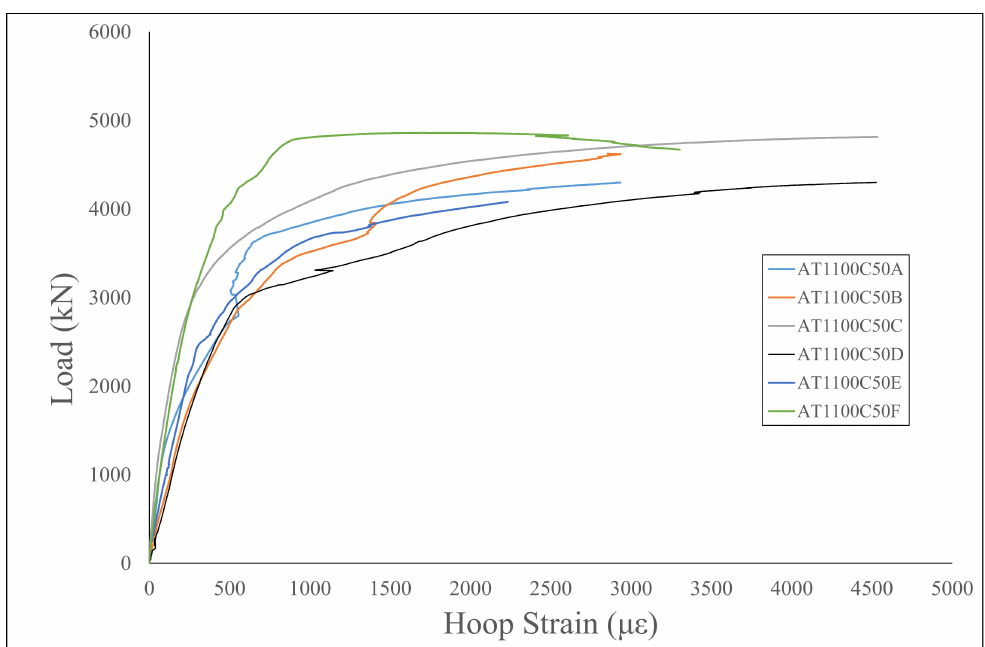
Figure 11. Load versus hoop strain curves of specimen AT